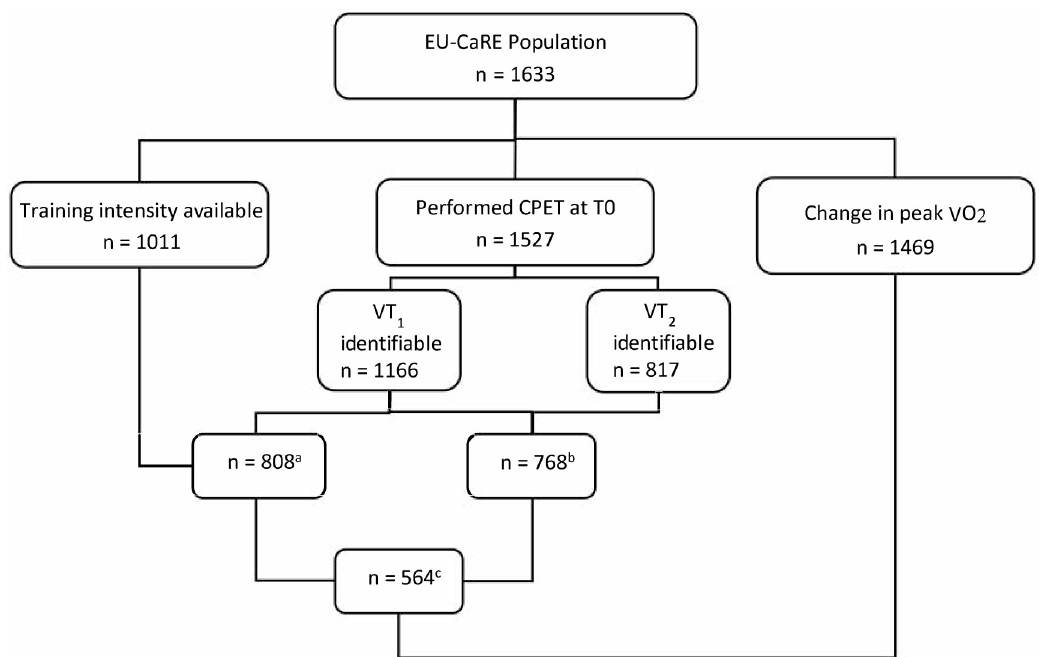
Fig 1. Flow-chart of available cases. N’s represent number of patients having data on training intensity and/or ventilatory thresholds and/or change in peak _ V _ O 2 . a Number of patients with available training intensity and identified VT 1 ; b Number of patients with available training intensity and identified VT 2 ; c Number of patients with available training intensity and identified VT 1 and VT 2 . CPET, cardiopulmonary exercise testing; _ V _ O 2 , oxygen consumption; T0, CPET at CR start; VT, ventilatory threshold.